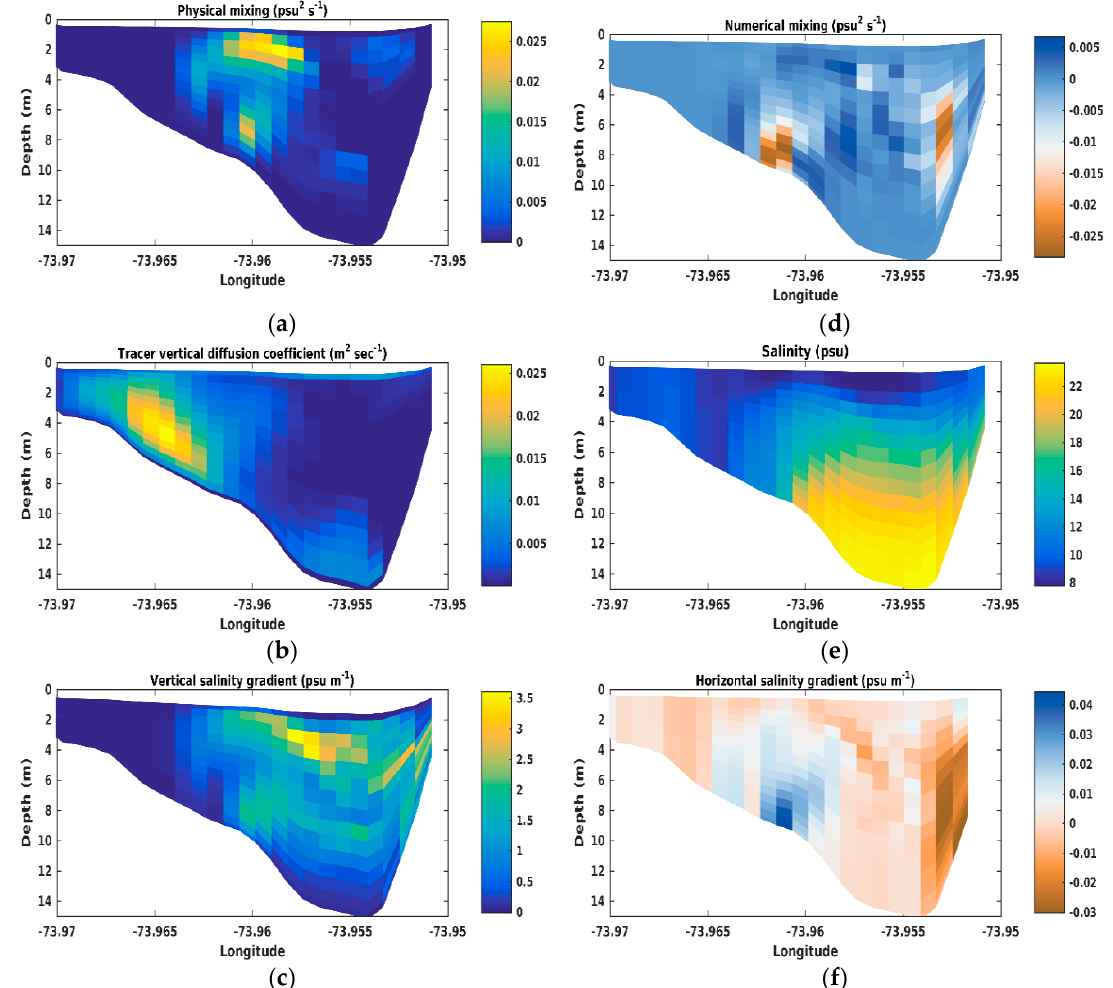
Figure 10. Hudson River estuary; Comparing instantaneous ( a ) Physical mixing, ( b ) Tracer vertical diffusion coefficient, ( c ) Vertical salinity gradient, ( d ) Numerical mixing, ( e ) Salinity, and ( f ) Horizontal salinity gradient at 1700 h on April 2, 2015 at a cross-section corresponding to a lateral front of 40.85°.